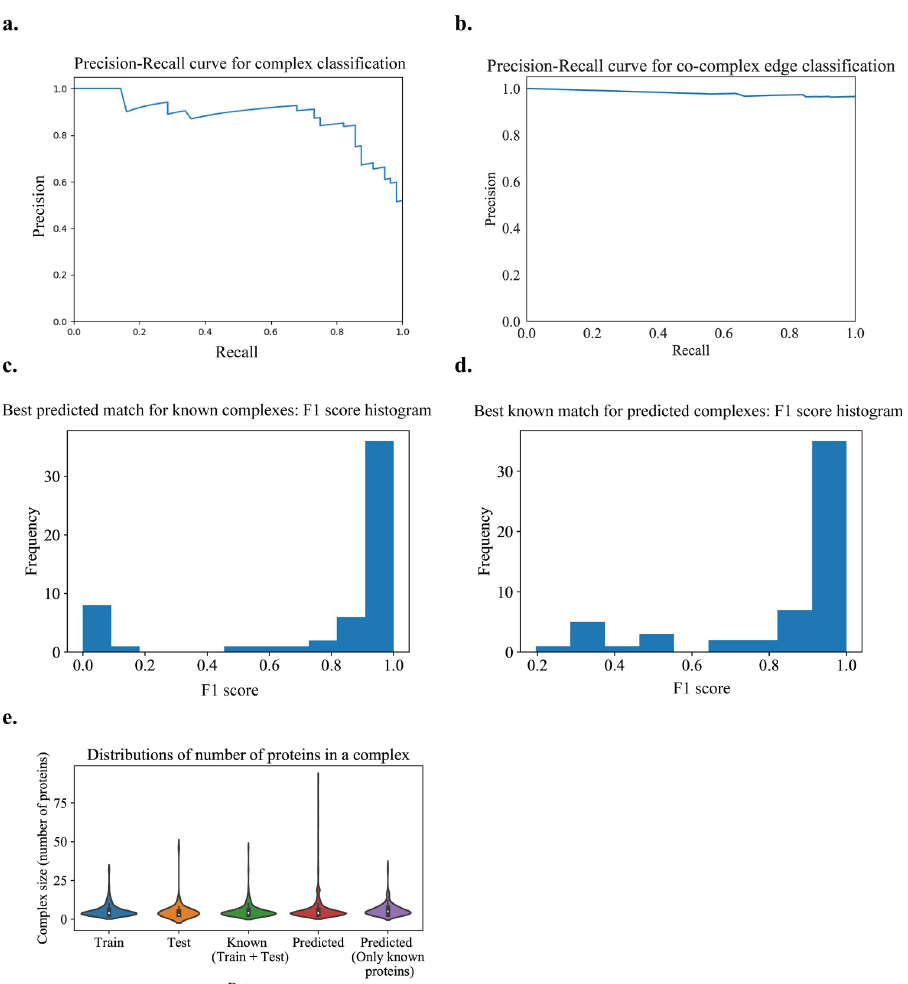
Fig 4. Learned human protein complexes with Super.Complex achieve good PR curves and follow similar size distributions as known complexes. a. PR curve for the best model (community fitness function) from the AutoML pipeline on the test dataset, for the task of classifying a subgraph as a community or not. b. Co-complex edge classification PR curve for final learned complexes. c & d. Best F-similarity score distributions per known complex and per learned complex. e. The size distributions of train, test, and all known complexes, learned complexes, and learned complexes after removing known complex proteins.